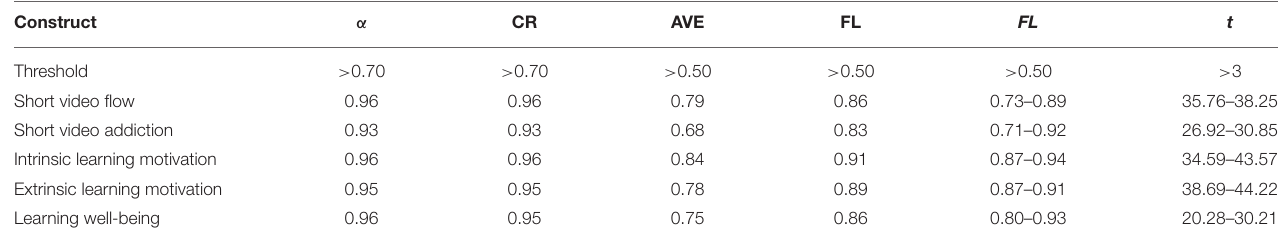
TABLE 1 | Analysis of validity and reliability.